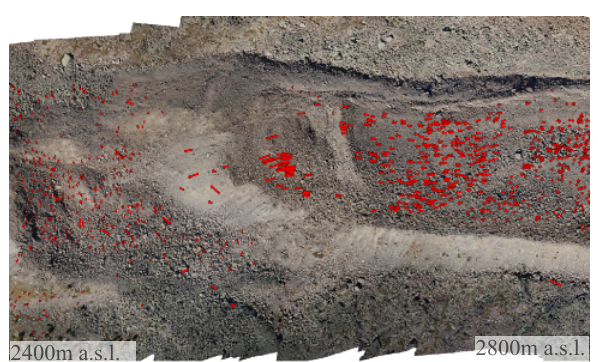
Figure 9. Tracked movement for the test site red: 2017-2018